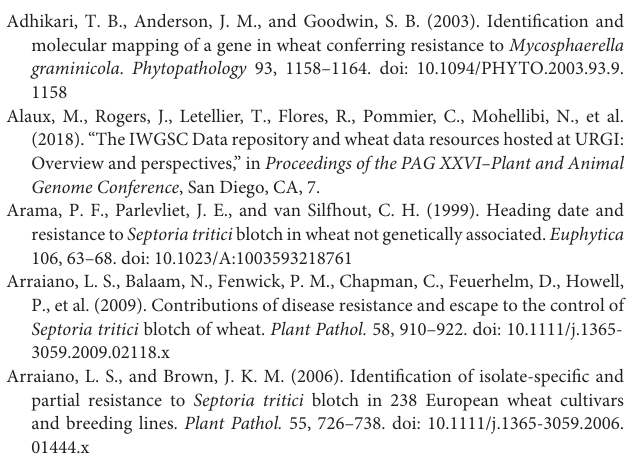
Supplementary Figure 3 | Manhattan plots displaying significant MTAs for STB resistance in SAMP bread wheat panel using MLM model in Tassel (v 5.2.53) at seedling (SRT) stage for STB isolates SAT2 (A) , 71-R3 (B) , and at the adult plant stage (APS) for MCH-17 (C) , SAT-17 (D) , and SAT-18 (E) . Supplementary Figure 4 | Manhattan plot displaying significant MTAs for days to heading (HD) in SAMP bread wheat panel using MLM model in Tassel (v v 5.2.53). Supplementary Table 1 | The list of genotypes included in the SAMP with pedigree information. Supplementary Table 2 | Zymoseptoria tritici isolates used in SRT and APR screening of advance bread wheat breeding lines included in SAMP. Supplementary Table 3 | Infection responses of wheat genotypes at the seedling (STB isolates; SAT-2, 71-R3), at the adult plant stage (MCH-17, SAT-17, SAT-18), and days to heading